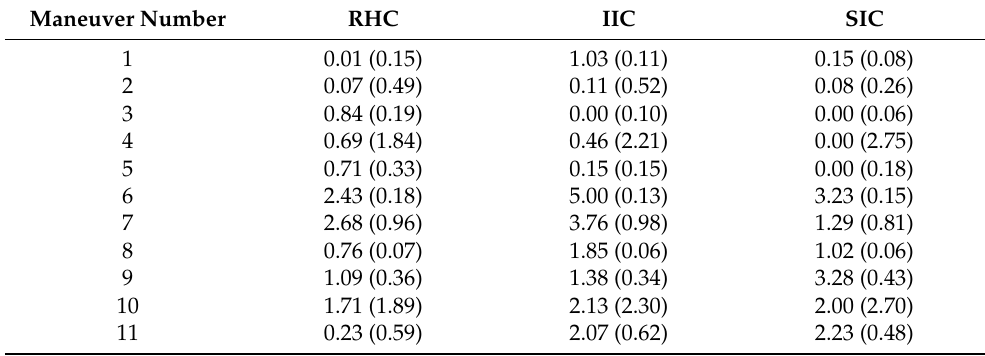
Table A1. Nadaraya–Watson estimates (bootstrapped standard error). From maneuver number 1 to